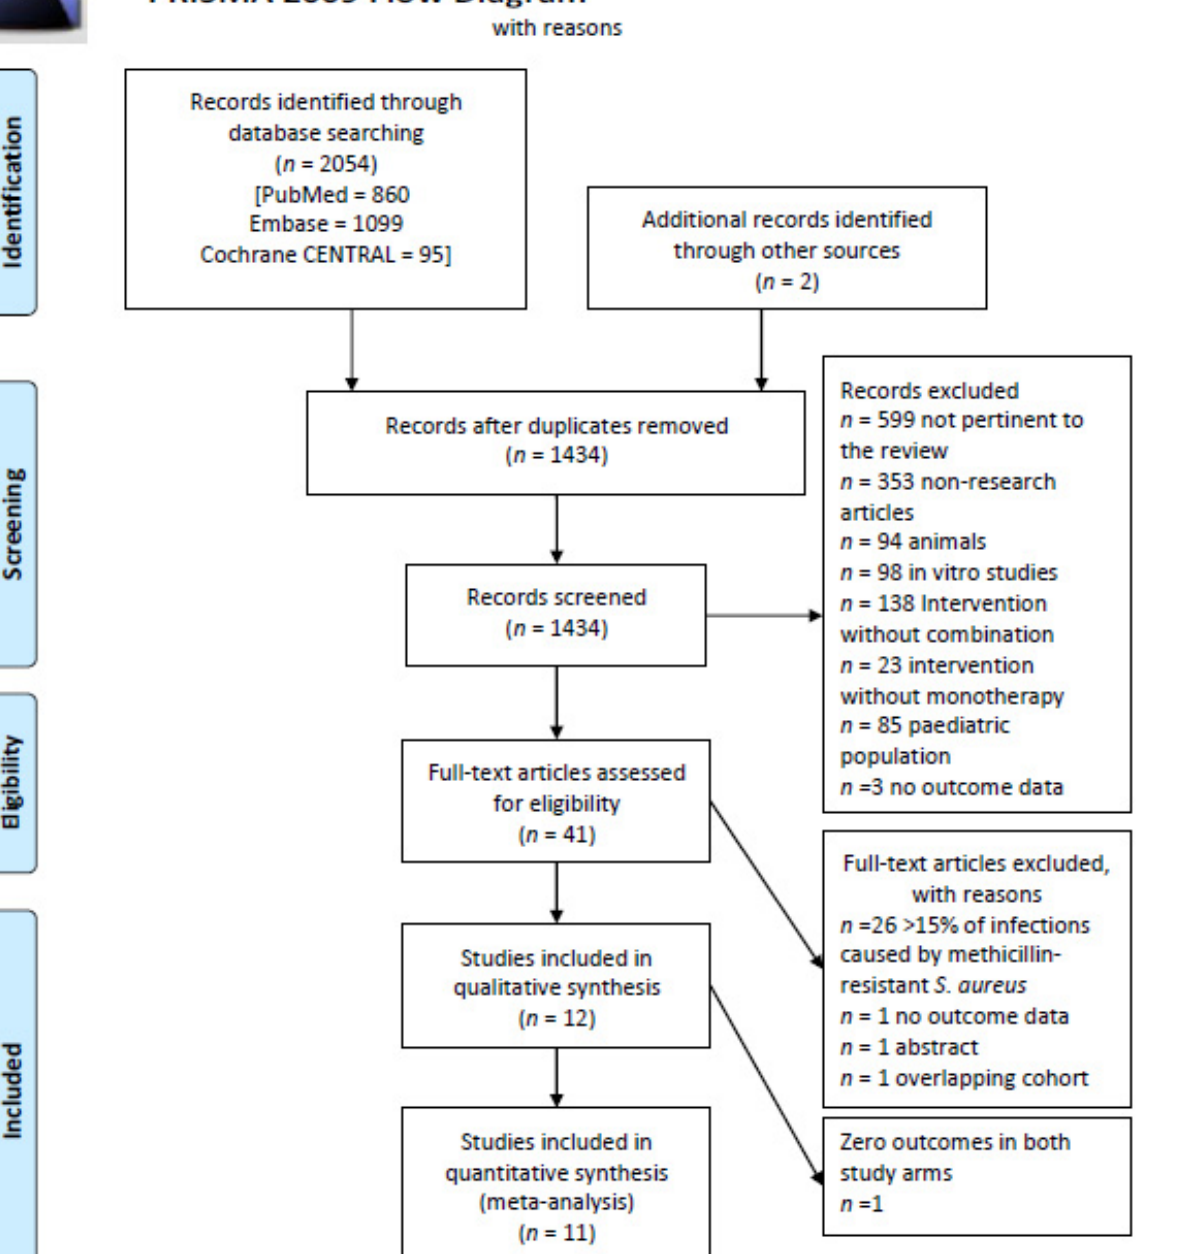
Figure 1. Flowchart of the selection of the studies.